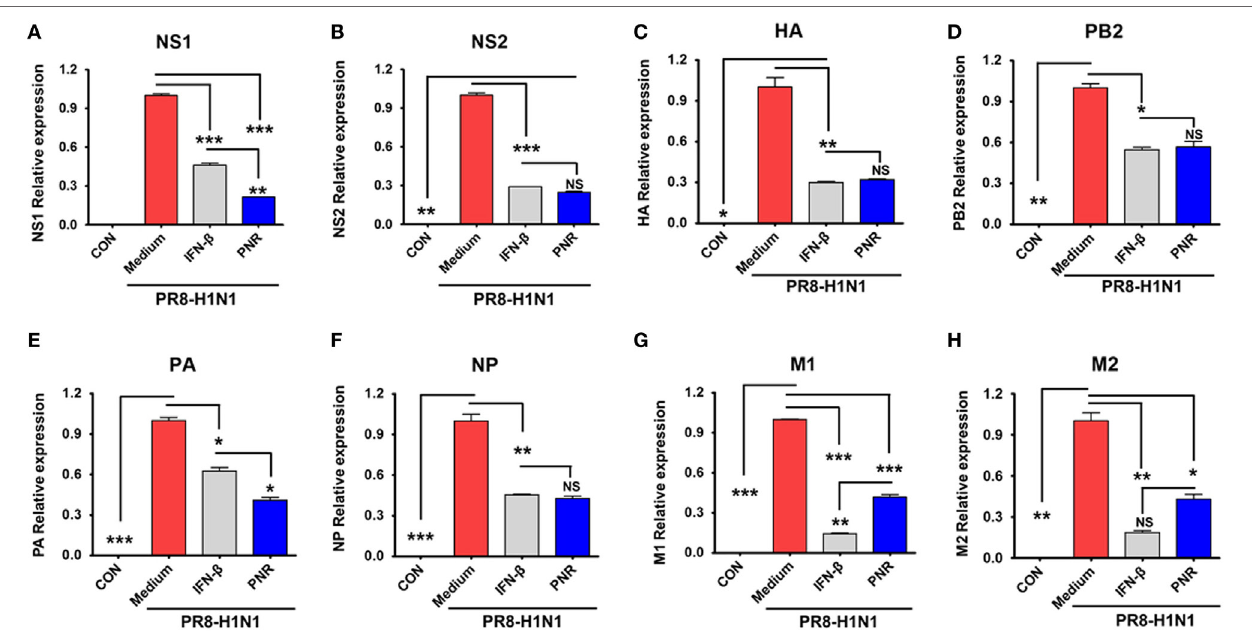
FigUre 5 | Effect of constituents from Panax notoginseng root (PNR) on influenza A/PR/8/34 mRNA synthesis. Pretreatment with PNR (100 µg/mL) and interferon (IFN)- β (1,000 U/mL) on influenza A/PR/8/34 (multiplicity of infection = 1)-infected RAW 264.7 cells and the relative mRNA levels of influenza A/PR/8/34 NS1 (a) , NS2 (B) , HA (c) , PB2 (D) , PA (e) , NP (F) , M1 (g) and M2 (h) were analyzed by quantitative real-time polymerase chain reaction and normalized to β -actin levels. Data are presented as the mean ± SD of three independent experiments. Bar graph (mean ± SEM) statistics were determined using two-way ANOVA with Bonferroni’s correction (post-test), *** P < 0.001; ** P < 0.01; * P < 0.05. n.s., not significant.